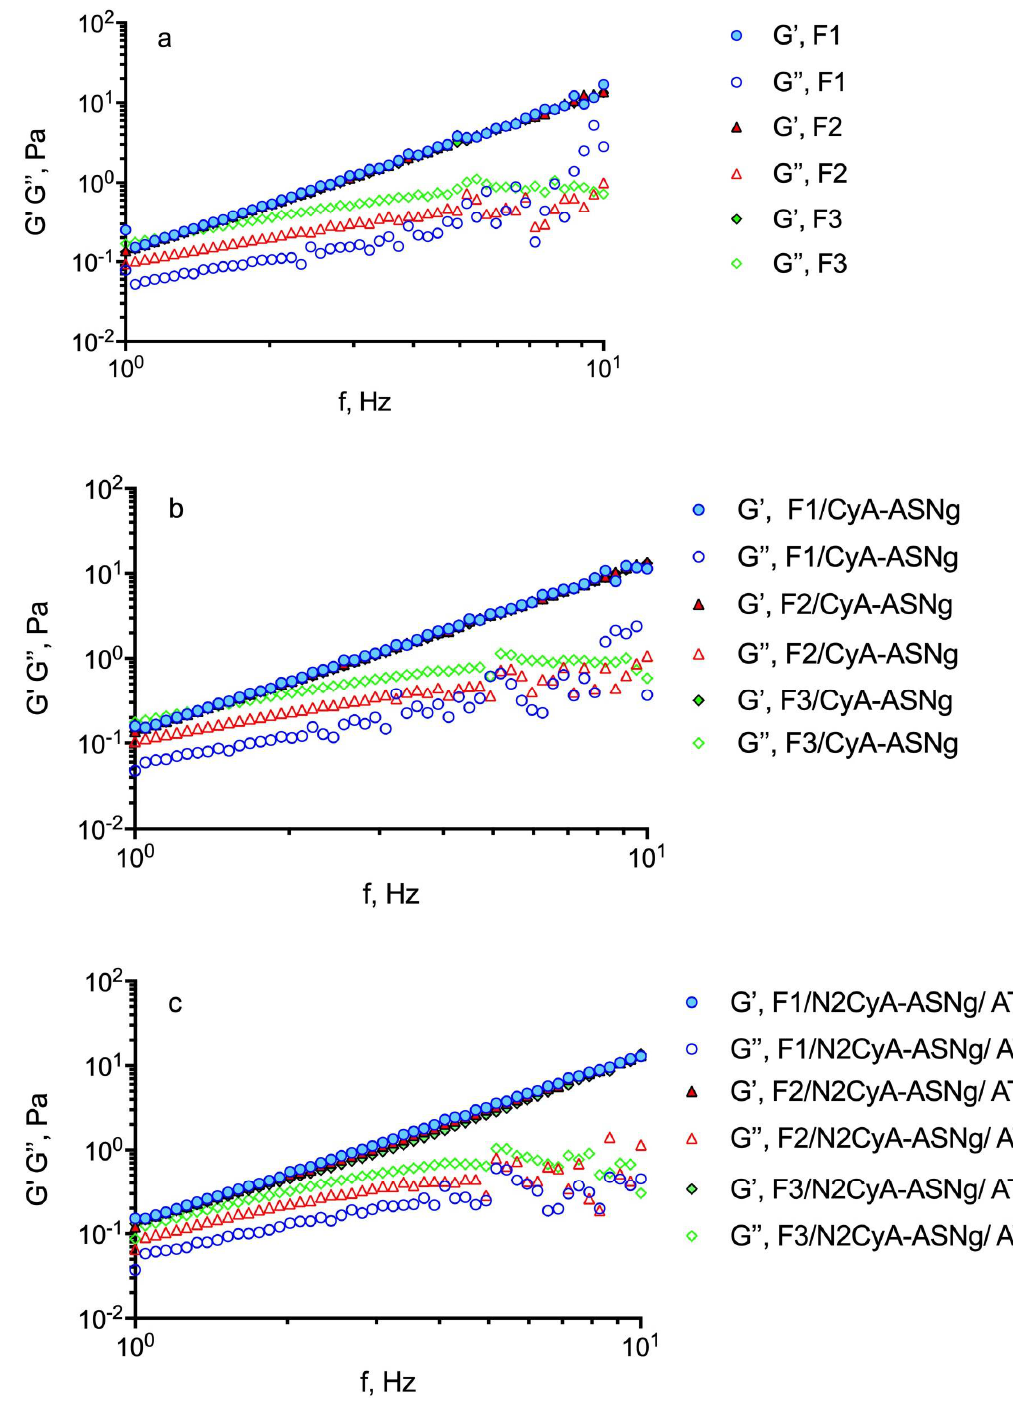
Figure 5. Influence of GG-LA concentration on the frequency dependence of the storage modulus (G’) (closed symbols) and the loss modulus (G”) (open symbols) of: ( a ) GG-LA dispersions (Fx), ( b ) GG-LA dispersions containing nanomicelles (Fx/CyA-ASNg) and ( c ) GG-LA dispersions containing nanomicelles mixed with artificial tear fluid (ATF) mixed in ratio 30:7